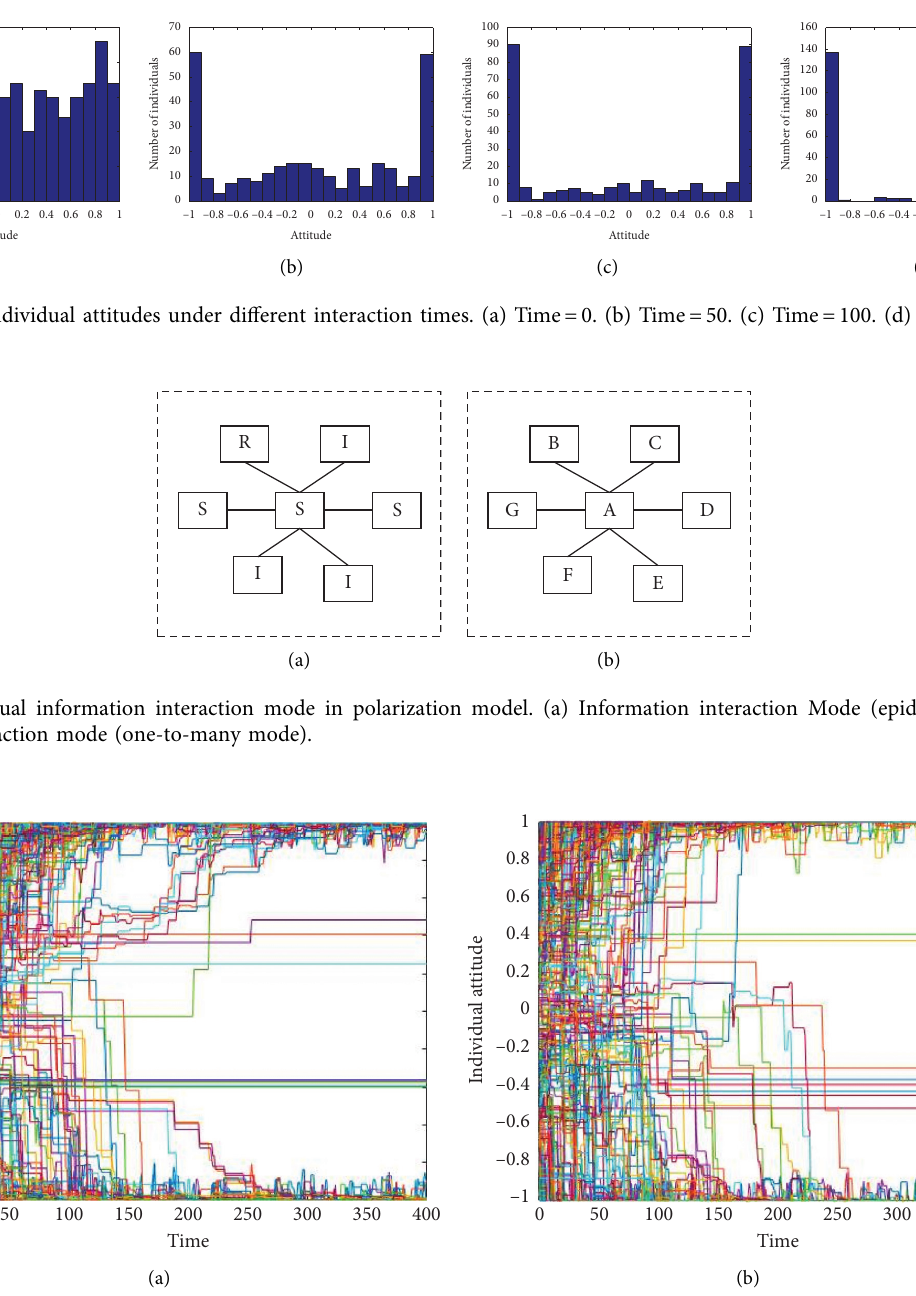
Figure 10: Individual attitudes with interactions in different interaction modes. (a) With epidemic mode. (b) With one-to-many